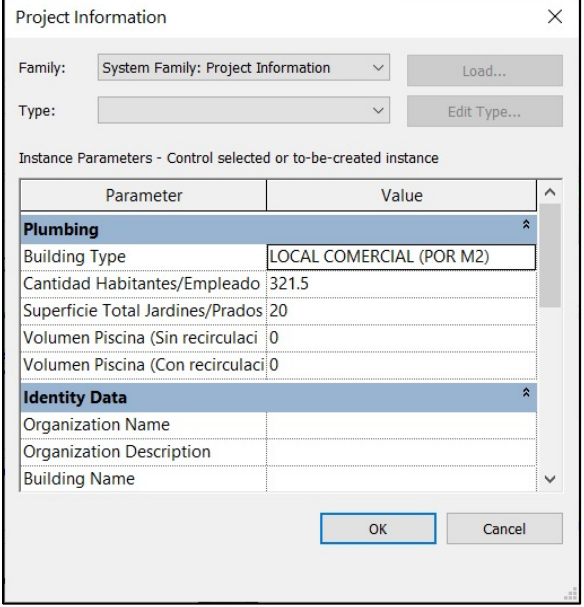
Figure 11. Project information chart for a retail building.